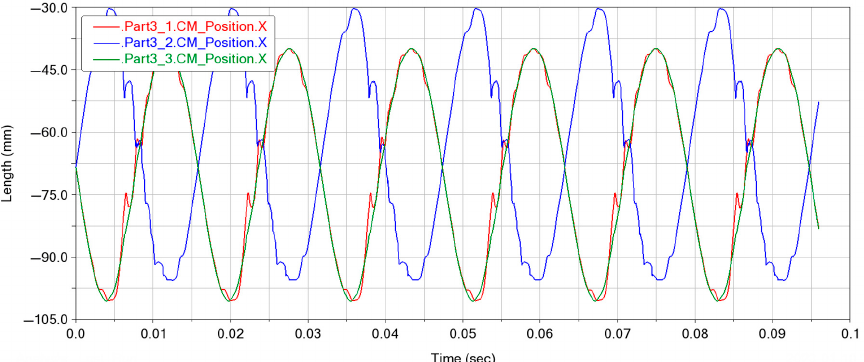
Figure 14. Engine piston acceleration diagram.